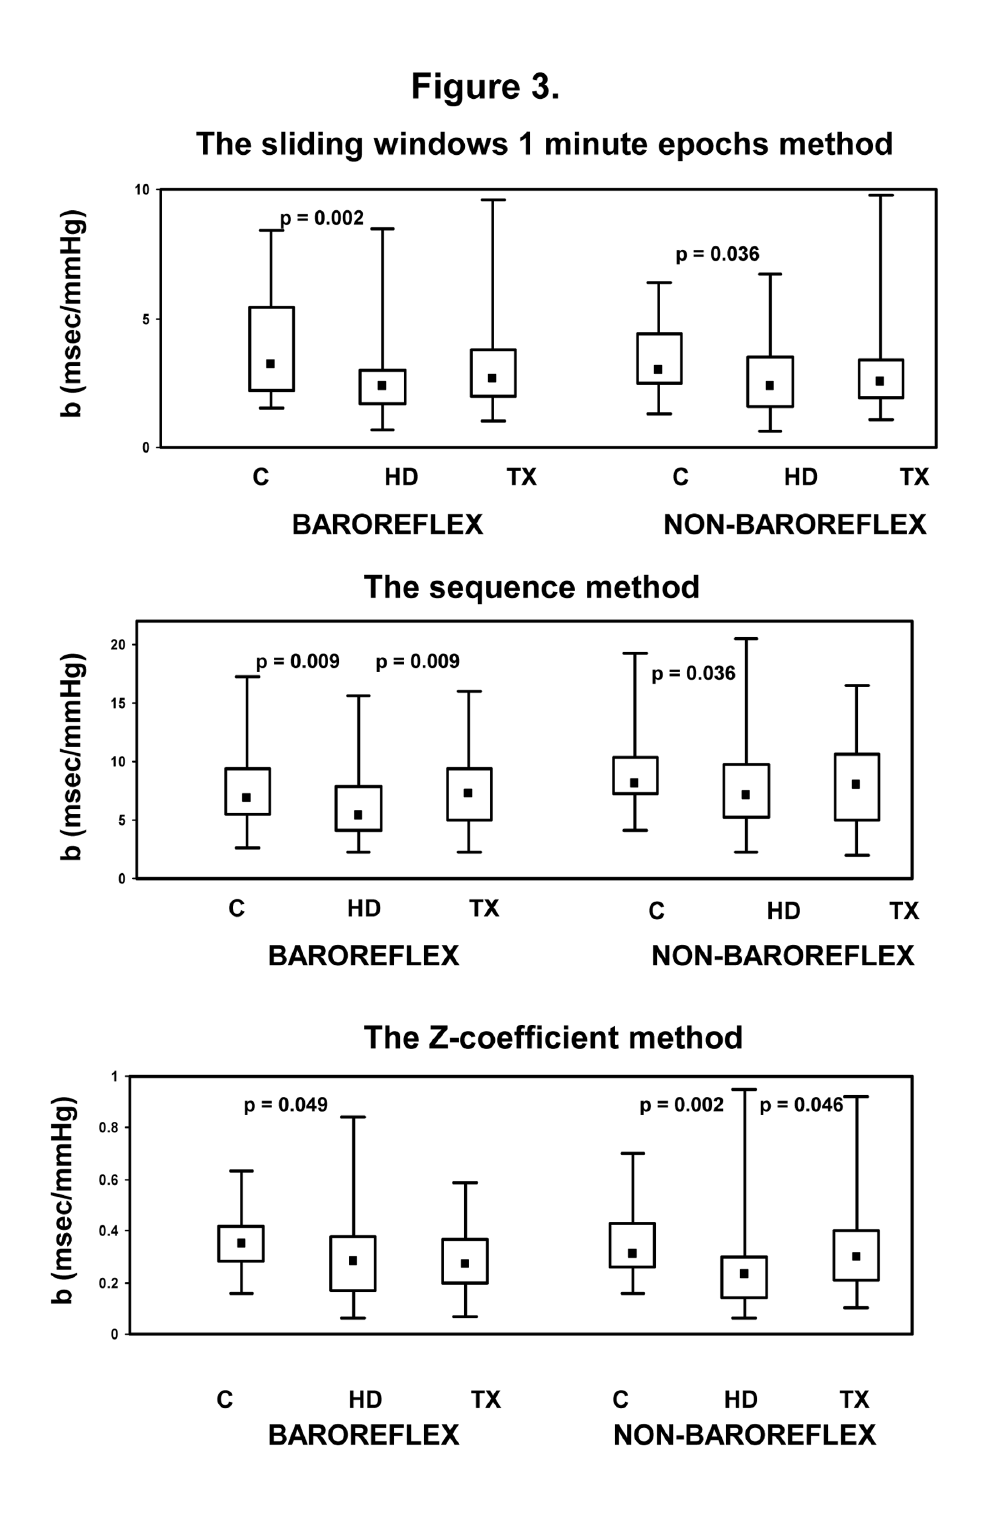
Figure 3. IBI-SBP regression slopes of baroreflex and nonbaroreflex episodes obtained by the 1 min sliding window analysis ( b ), by the sequence method ( b ), and by the "Z" technique ( b ) in control (C, •), in hemodialysis (HD, ♦) and in al seq z transplanted (TX,■) patients.